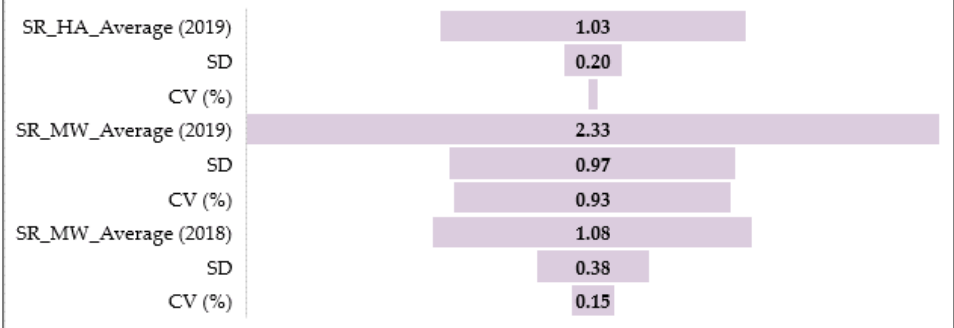
Figure 5. Summary data for stem rust severity in spring barley accessions phenotyped under field conditions in 2018–2019. Average value of disease severity, SD ( p ≤ 0.05 ) and CV (%) at the heading (SR_HA) and milky-waxy (SR_MW) stages in 2019 and at the milky-waxy (SR_MW) stage in 2018. Disease severity was scored on the 1–9 scale (1 = immune reaction).